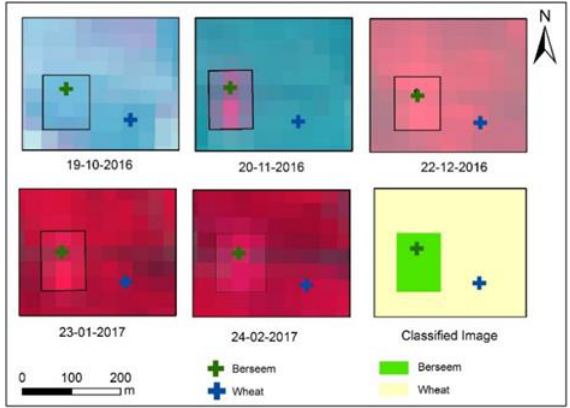
Figure 3. The tonal variation in reflectance for Berseem and Wheat